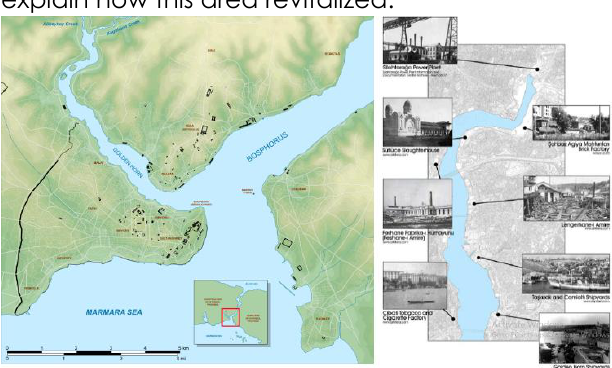
Figure 3. Golden Horn and important industrial districts (Aksoy, 2007).